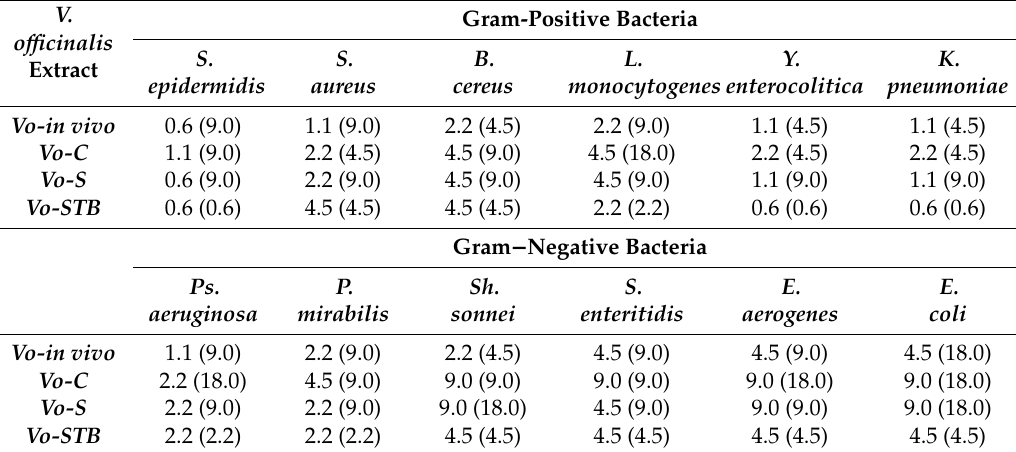
Table 4. MIC and (MBC) values (mg / mL) of V. o ffi cinalis